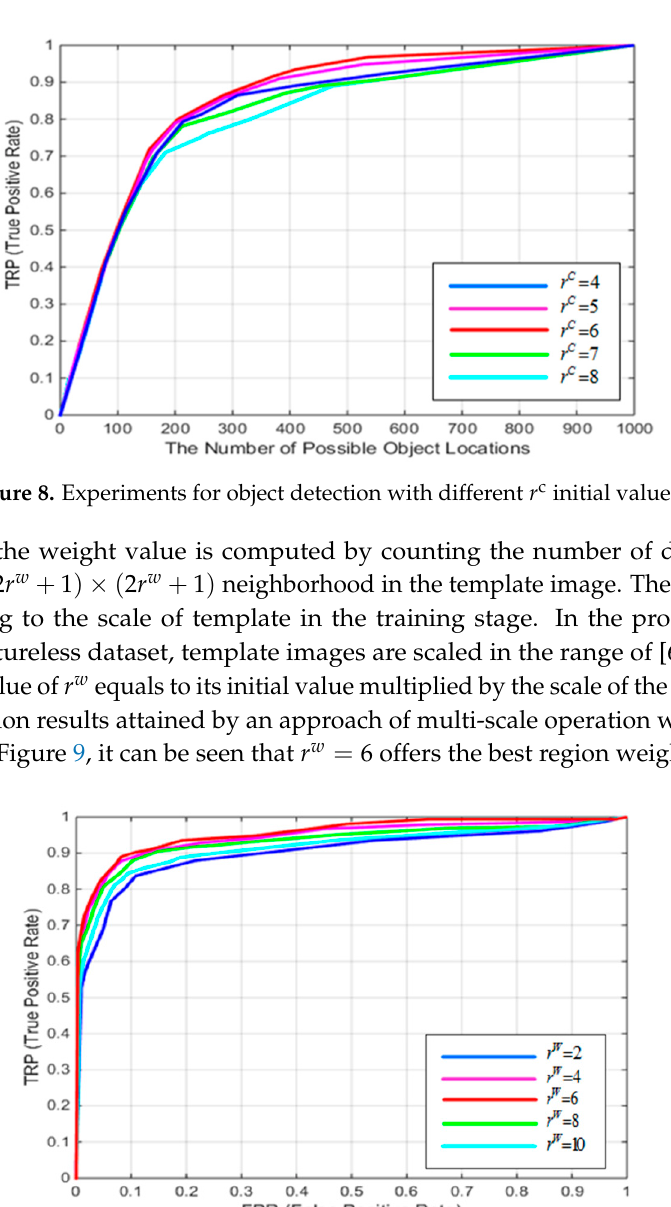
Figure 9. Experiments for object detection with different r w initial